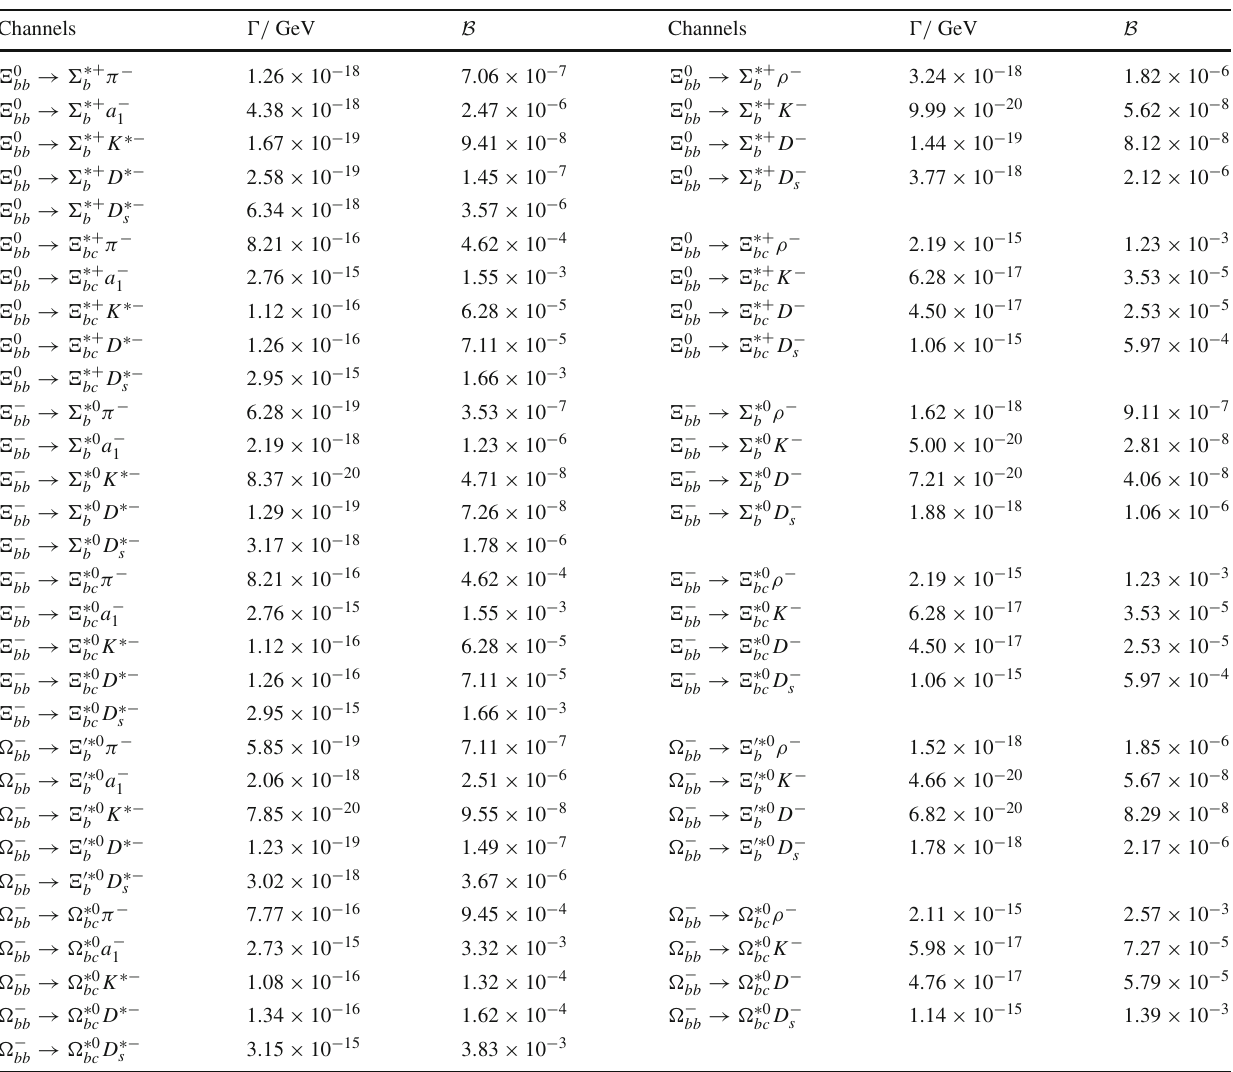
Table 17 Nonleptonic decays for the bb sector